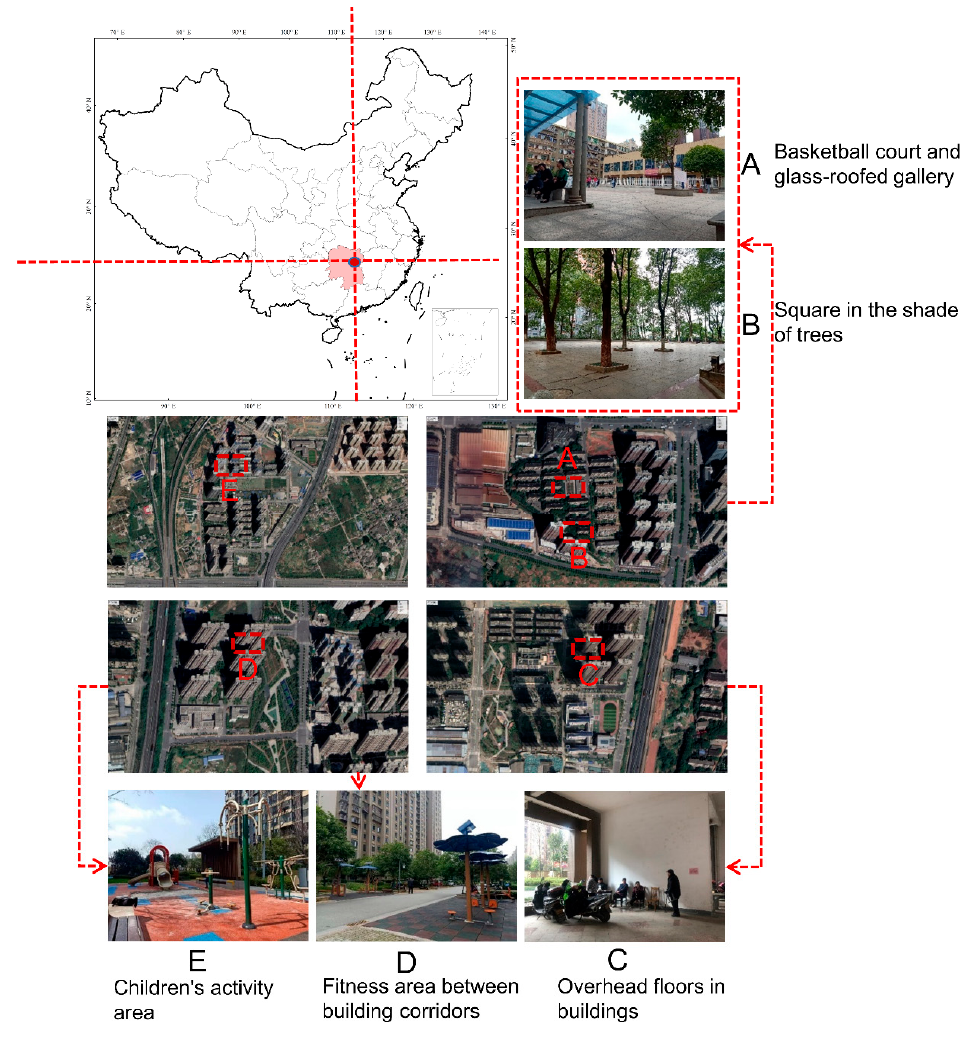
Figure 1. Location of the study areas.